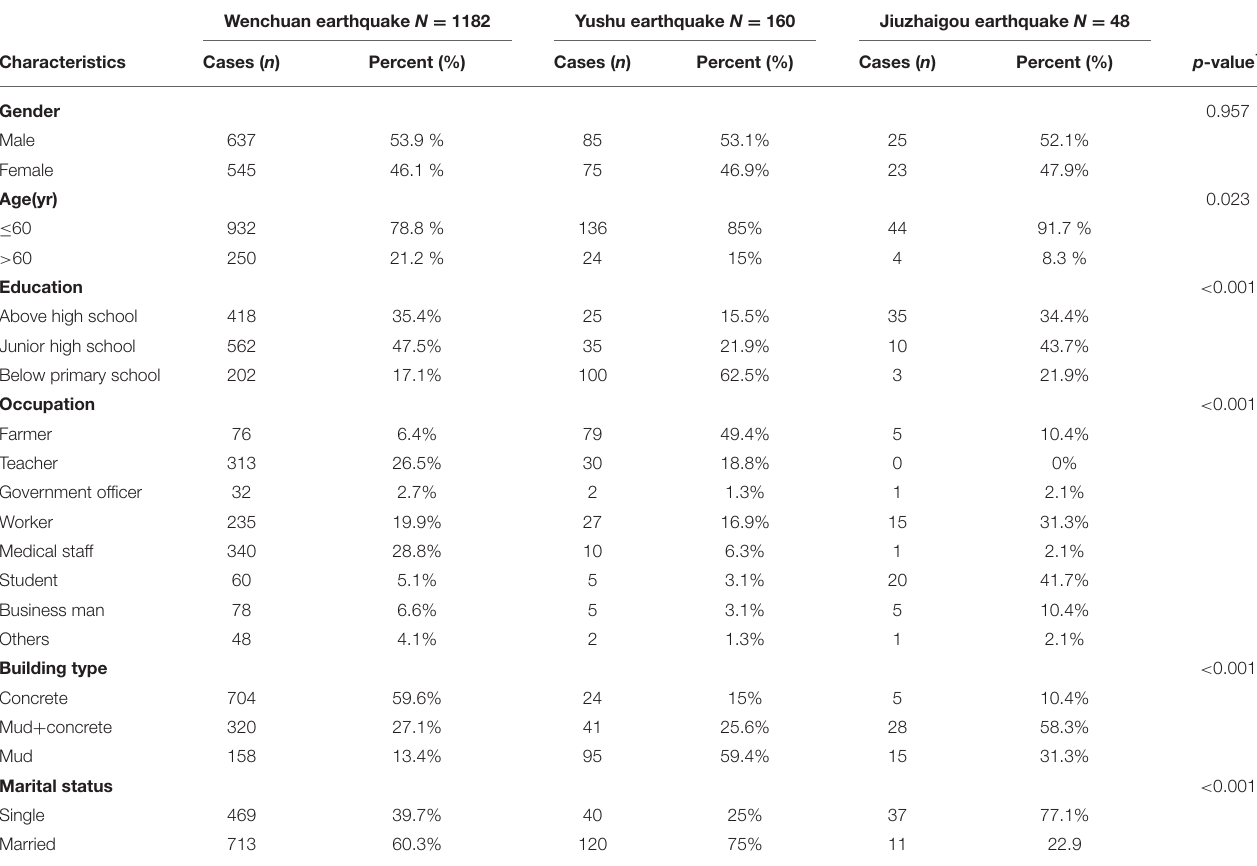
TABLE 1 | The general characteristics of Wenchuan, Yushu, and Jiuzhaigou earthquake patients. Wenchuan earthquake N =